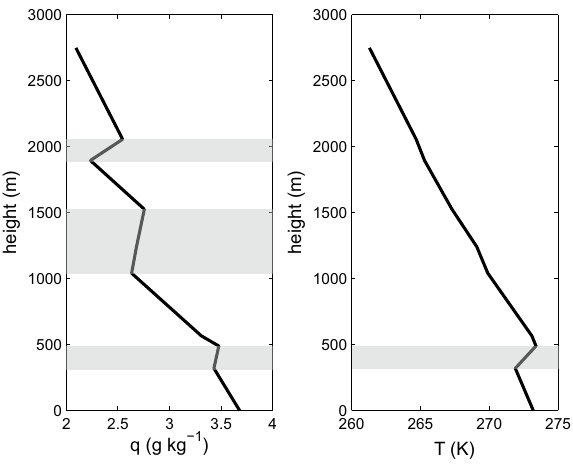
Fig. 2. Specific humidity and temperature profiles observed in Alert on 22 August 2005, 00:00UTC. The grey shading marks the inver- sion